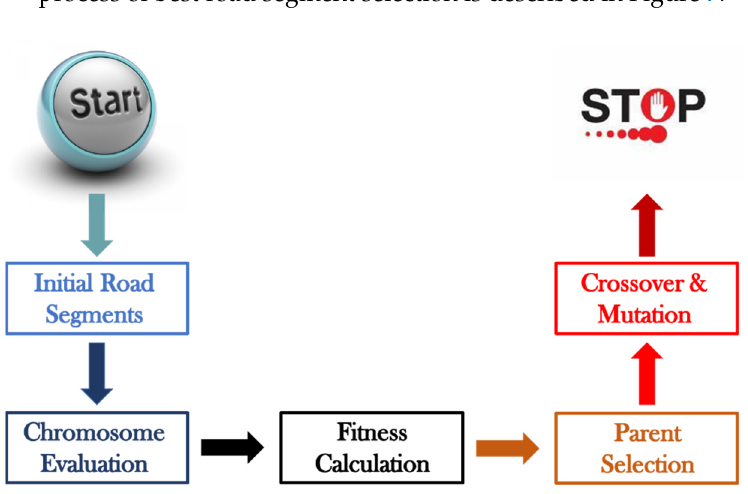
Figure 7. Best Road Segment